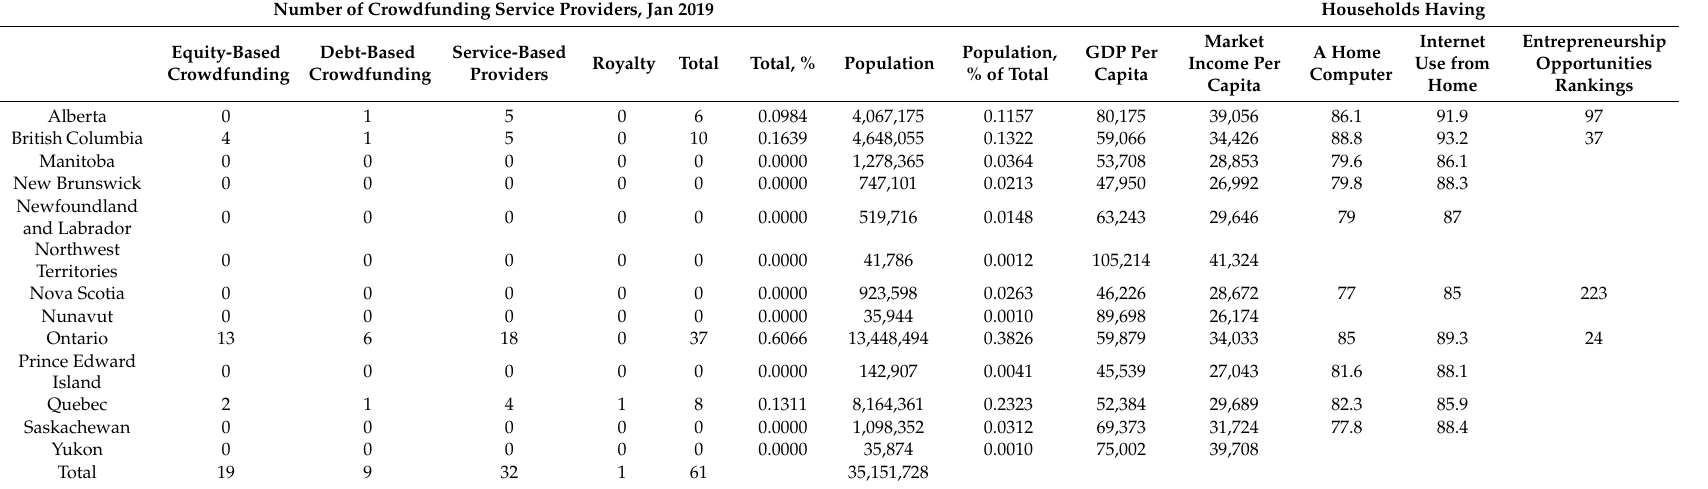
Table 9. Crowdfunding statistics for